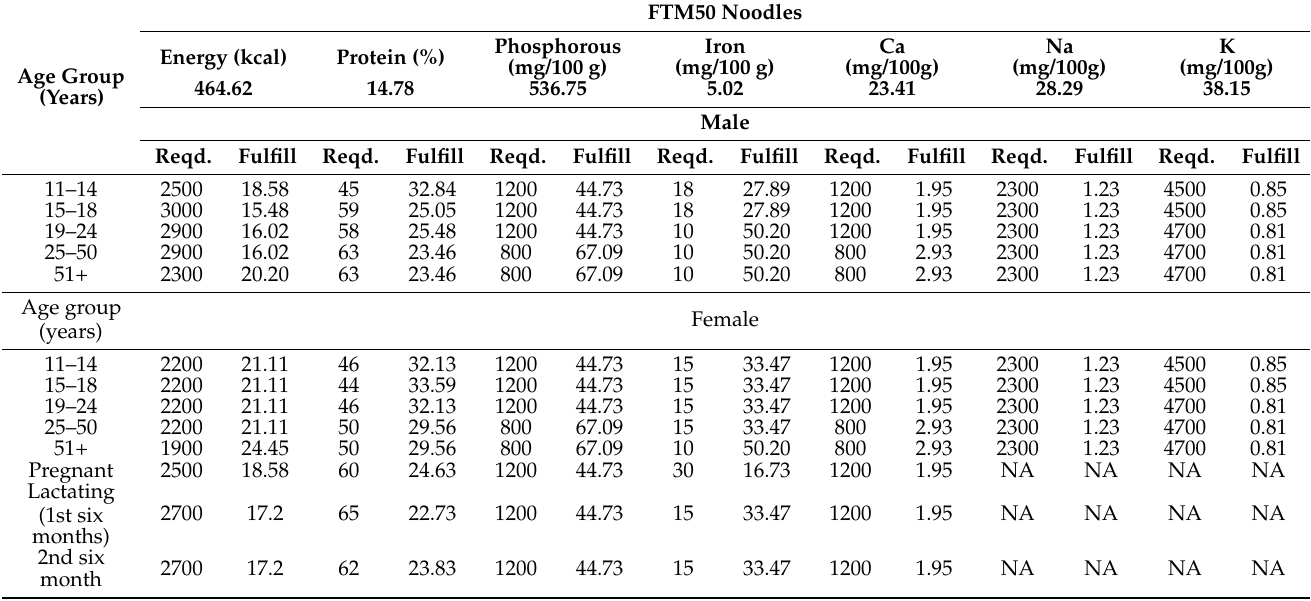
Table 4. Nutrient contribution of FTM50 noodles with respect to RDA 1